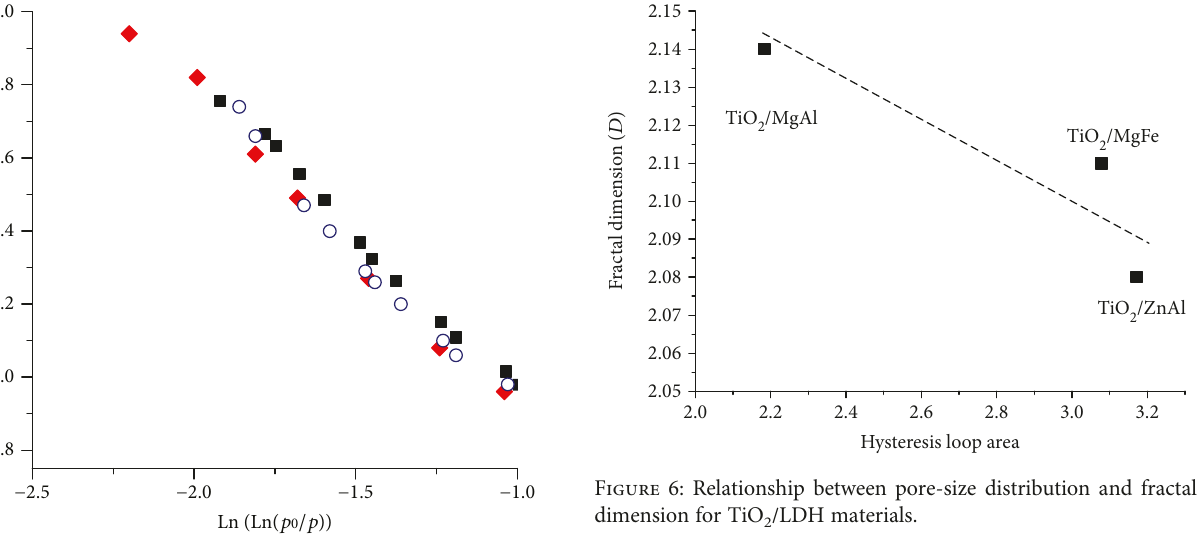
adsorption isotherms using the 2 /LDH materials. 2